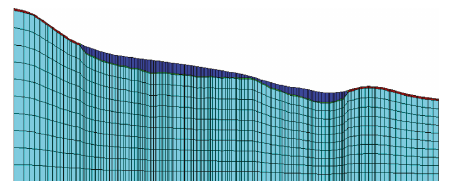
Figure 17: Sectional view of the model of Dasha